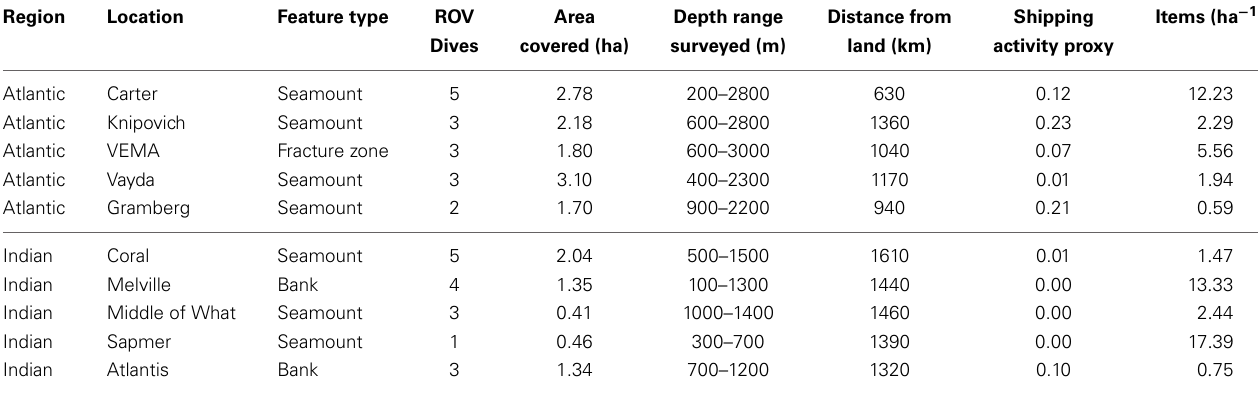
Table 1 | Sampling data including geomorphological feature surveyed, number of remotely operated vehicle (ROV) dives, area of ROV survey, depth range surveyed, distance from land, shipping activity proxy and litter